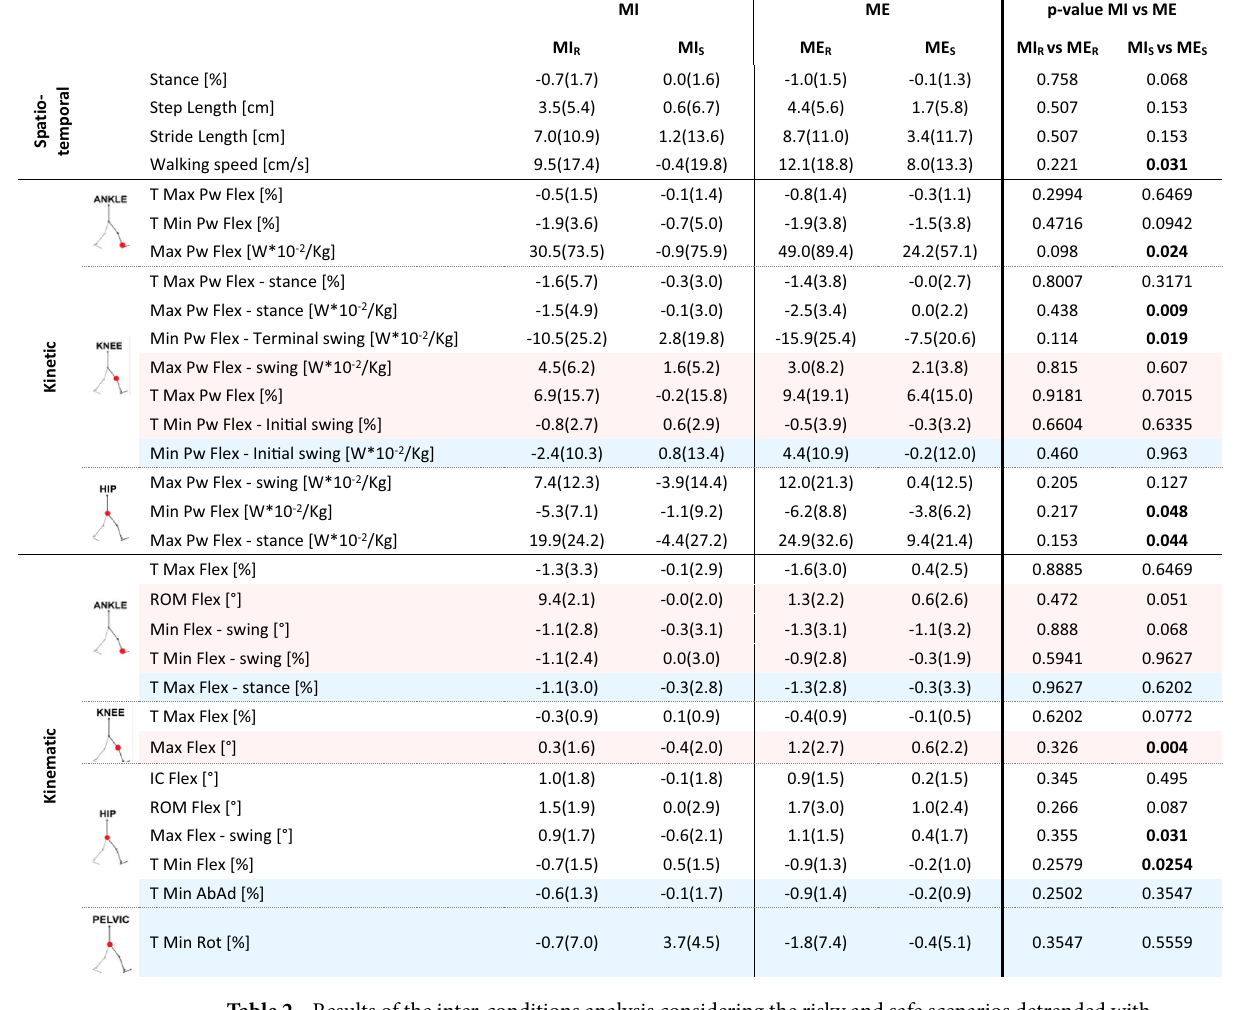
Table 2. Results of the inter-conditions analysis considering the risky and safe scenarios detrended with respect to the baseline are presented. All parameters described in Table 1 are included (that is all parameters satisfying the “risky-scenario-driven” approach; i.e., significant differences in BR as well as in SR in at least one condition). Median and IQR values of the detrended parameters are reported (see Eqs. 1–4 in the Data Analysis section). P-values refer to the Wilcoxon test between MI and ME (i.e., MI R vs. ME R ; MI S vs. ME S ). Statistically significant values are in bold. To improve readability, colors conventions correspond to the ones in Table 1 (i.e., parameters having significant differences in BR as well as SR in both MI and ME condition are reported on white background; parameters having significant in BR as well as SR only in the MI condition are reported on pink background; parameters having significant differences in BR as well as in SR only in the ME condition are reported on light blue background). MI: Motor Interference condition, ME: Motor Expectation condition, MI S : Motor Interference Safe (detrended), MI R : Motor Interference Risky (detrended); ME S : Motor Expectation Safe (detrended), ME R : Motor Expectation Risky